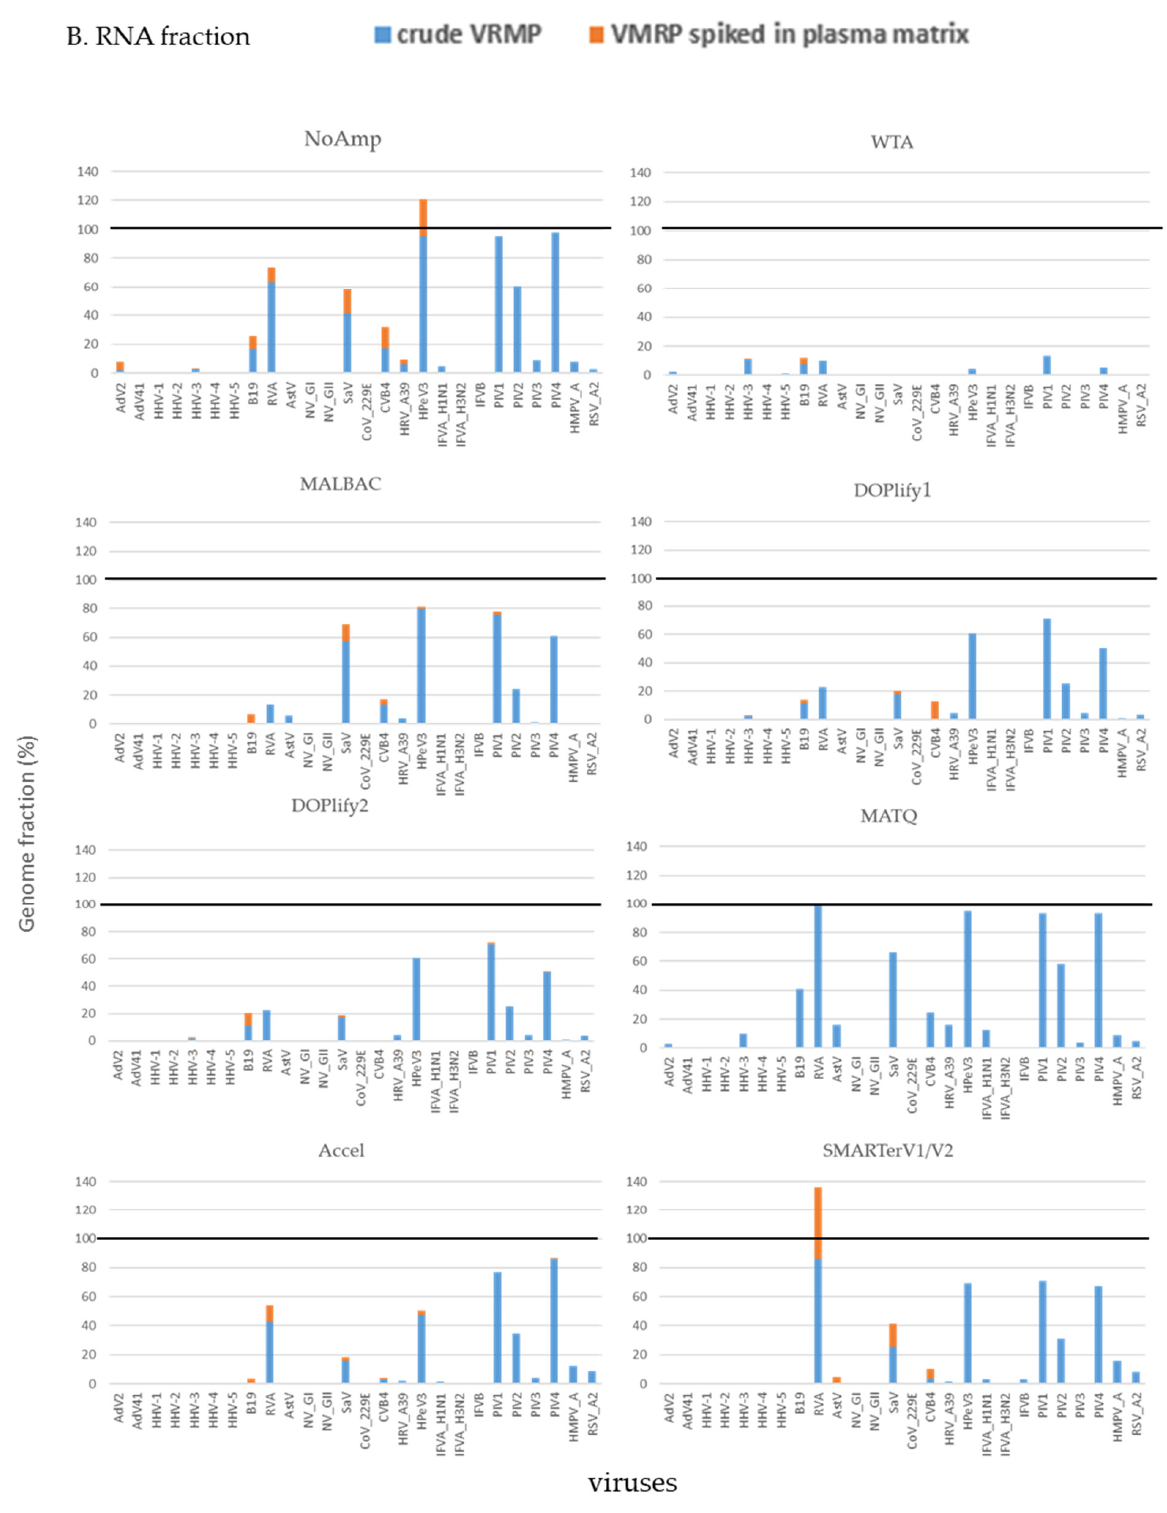
Figure 5. Combined results of virus detection genome fraction of viruses detected in crude VMRP and in VMRP spiked in plasma sample with seven methods and viral detection in VMRP spiked in plasma sample. ( A ) in NA fraction; ( B ) in RNA fraction. Stacked histogram represents the genome fraction (%) in crude VMRP (blue) and in spiked plasma matrix (orange). DOPlify1 and DOPlify2 referred at different number of amplification cycles. Note that MATQ was not assessed in plasma sample.